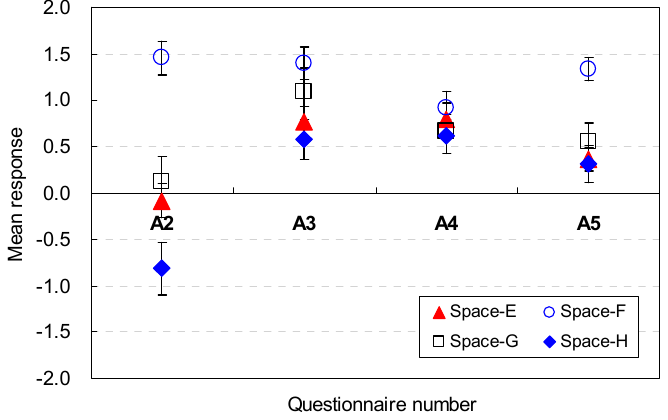
Figure 6. Spatial perception of the spatial size in terms of amenity under floor layout changes.